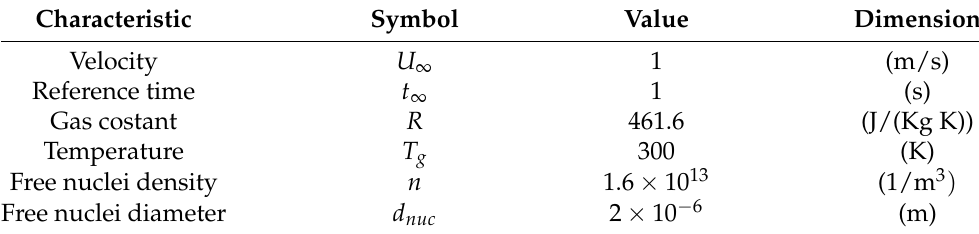
Table 7. Set up of parameters contained in the cavitation